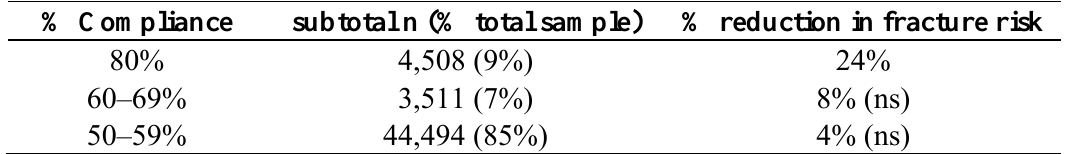
Table 2. Population sub-groups reduction in total fracture risk with calcium supplementation: meta-analysis. Reproduced from